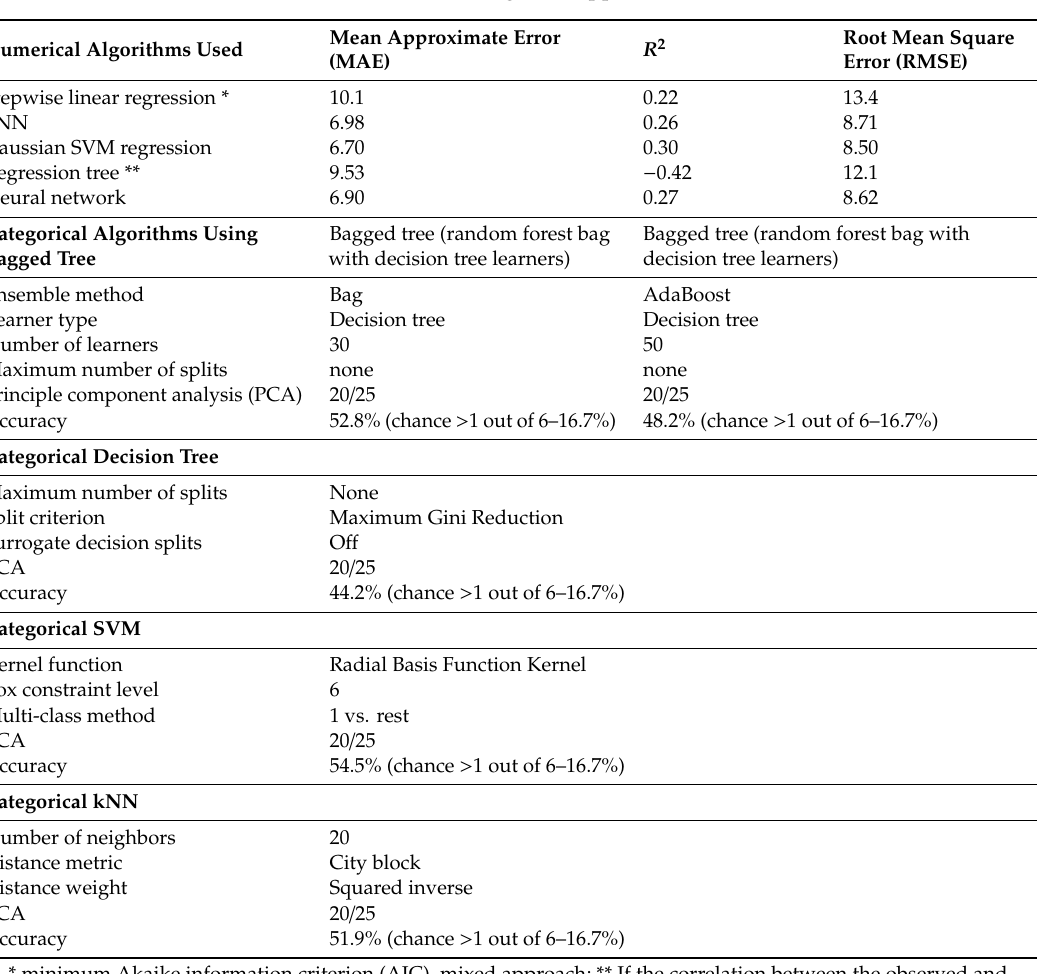
Table 2. Numerical and categorical approach summaries.